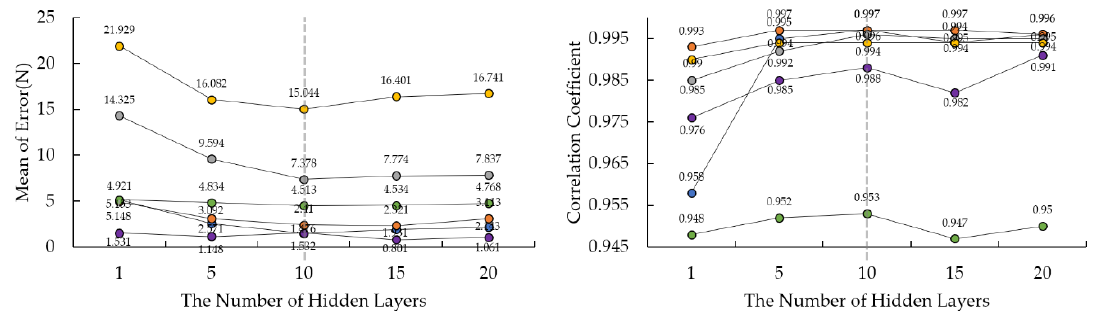
Figure 3. Picture of experimental setup. All experiments were done wearing the F-Scan system in-shoe sensor and low-cost FSR foot sensor simultaneously. (1), (2), (3) represents the shoe, developed FSR foot sensor, and the F-Scan in-shoe sensor respectively. And they are piled up in order.